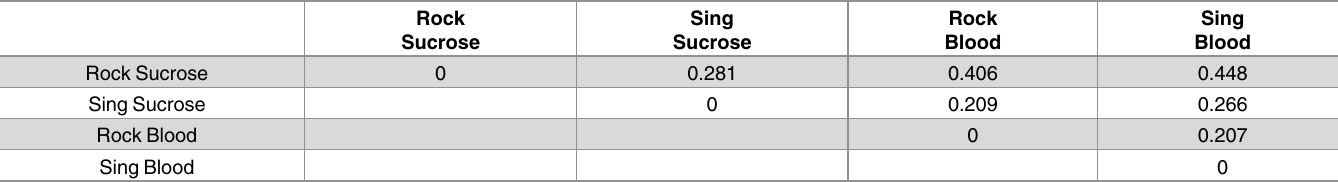
Table 1. Weighted UniFrac distances between Rock and Sing microbiome